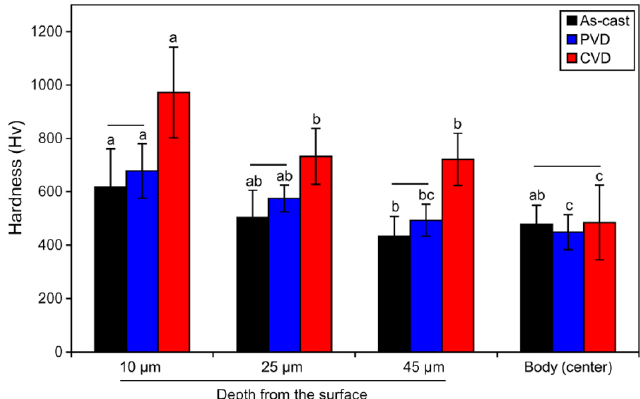
Figure 10. Nano-indentation hardness values measured at depths of 10, 25, and 45 μ m and at the center of the cross-sectioned surface of the as-cast, PVD-coated, and CVD-coated alloys. Each value was converted into Vickers hardness (Hv) values. The horizontal bars connect statistically equivalent values among the three coating conditions within each depth condition ( p > 0.05). The same small case letters above the bars indicate statistically similar means among the four depth conditions within each coating ( p > 0.05).